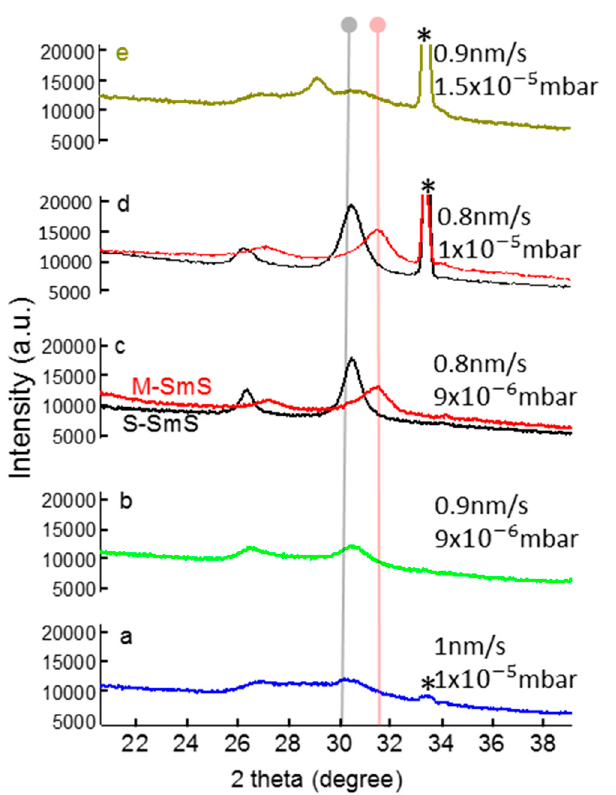
Figure 2. XRD patterns for 100 nm thick films as a function of the deposition rate (in nm/s) and the H 2 S pressure (mbar), for a substrate temperature of 250 °C. Grey and pink vertical lines represent the position of the (200) diffraction peak, for S-SmS and metallic state SmS (M-SmS) bulk crystals [14], respectively. For the thin film in graphs c and d, also the diffraction patterns for the thin film switched to the metallic state are shown, in red. The peak at ~33.3° is an artefact, related to the Si substrate (indicated with *).